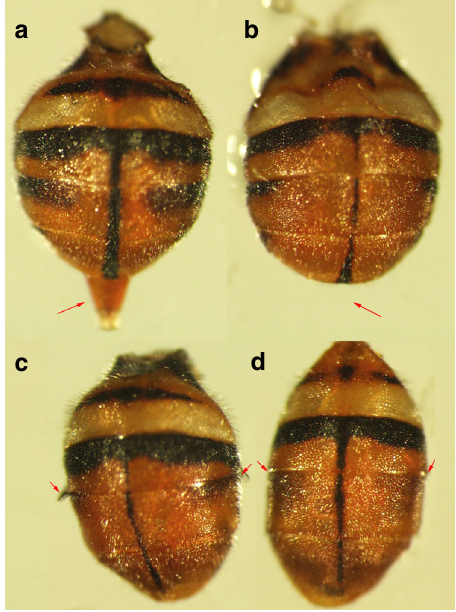
Fig. 5 Dorsal view of abdominal intersex phenotypes induced by embryonic injection. a Wild type female adult, ( b ) intersex of incomplete masculinization individuals exhibiting a female dorsal phenotype but lacking the ovipositor after miR-1-3p agomir injection, ( c ) dorsal overview of WT male adult, and ( d ) intersex due to incomplete feminization exhibiting a male dorsal phenotype without bristles on the side of the third tergum after the miR-1-3p antagomir and sgRNA